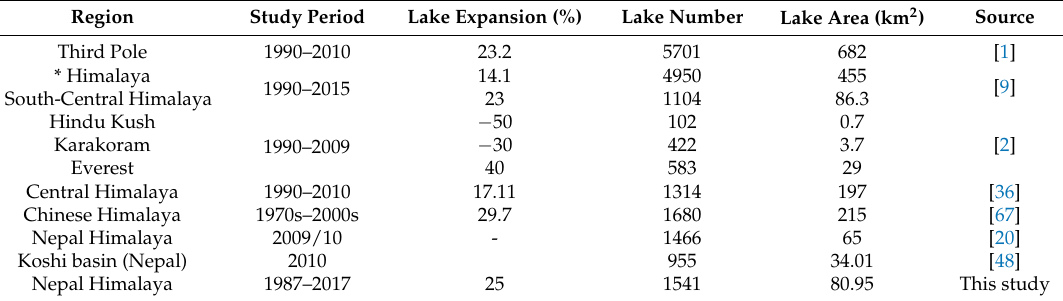
Table 4. Glacial lake number and expansion (%) in different